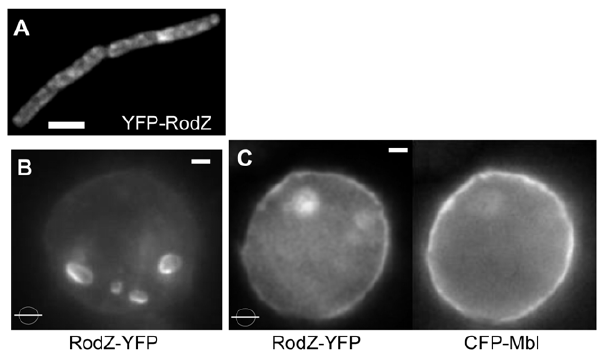
Figure 6. Recruitment of proteins to Mbl-membrane structures. A) Localization of YFP-RodZ in Bacillus subtilis cells. B) Membrane protein RodZ-YFP expressed in S2 cells by itself, or C) together with CFP-Mbl. White bars 2 m